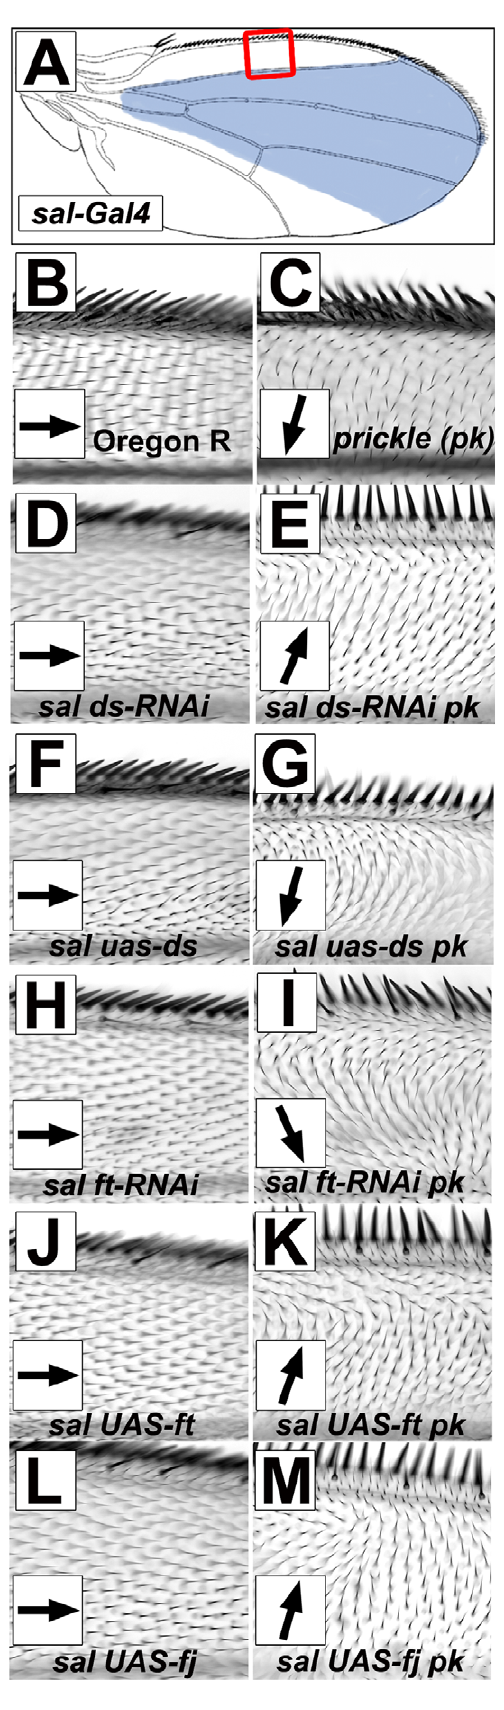
Figure 7. Gradients/boundaries of Ft/Ds pathway gene expres- sion modify the pk pk hair polarity phenotype. All micrographs show a detail of the A region of the female dorsal wing (red boxed region in (A)). Black arrows indicate local hair polarity. (A) Wing cartoon showing major expression domain of the sal-Gal4 driver (blue shading). (B) Wild-type (Oregon R). (C) pk 30 / pk 30 . (D) sal-Gal4/UAS-ds(IR) . (E) pk 30 , UAS-ds(IR)/pk 30 , sal-Gal4 . (F) sal-Gal4 ; UAS-ds . (G) pk 30 sal-Gal4 / pk 30 ; UAS- ds . (H) sal-Gal4/UAS-ft(IR) . (I) pk 30 , UAS-ft(IR)/pk 30 , sal-Gal4 . (J) sal-Gal4/ UAS-ft . (K) pk 30 , sal-Gal4/pk 30 , UAS-ft . (L) sal-Gal4/UAS-fj . (M) pk 30 , sal- Gal4/pk 30 , UAS-fj